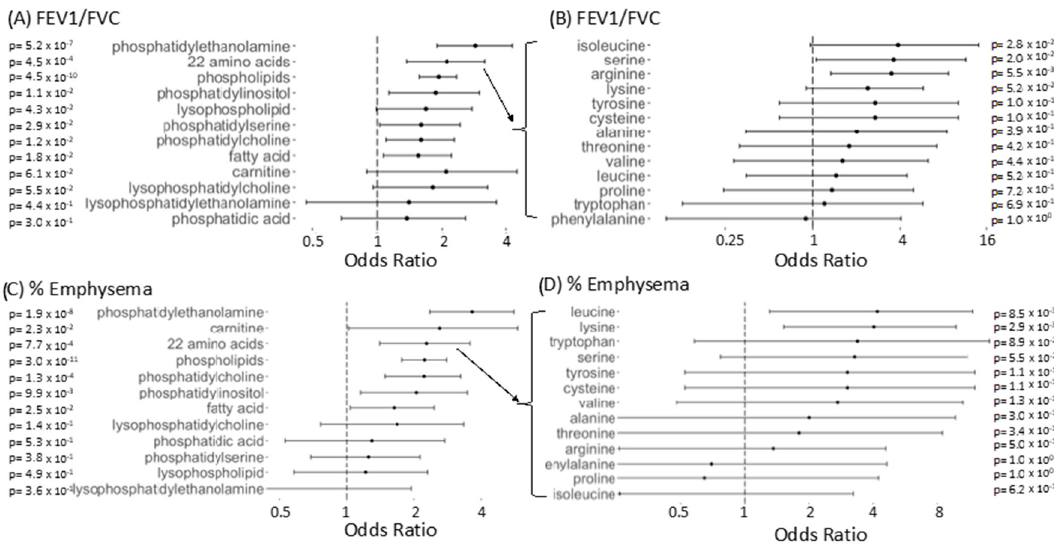
Figure 3. EnrichmentofcompoundclassesinBALcompoundsassociatedwithFEV 1 / FVCand%Emphysema). ( A ) Odds ratio with 95% confidence intervals for compounds in a given category to appear among the FDR corrected FEV 1 / FVC associated compounds versus appearing among non-associated compounds, using Fisher’s exact test. Regular expression searches identified compounds of different categories with matching compounds checked manually for accurate categorization. ( B ) Same as A (top left) but for more specific amino acid containing compounds. Categories shown in B include amino acid containing compounds for amino acids with > 10 compounds detected experiment-wide for BAL. In B, a compound need only contain the compound listed to be included. ( C ) Same as A for % Emphysema ( D ) Same as B for %